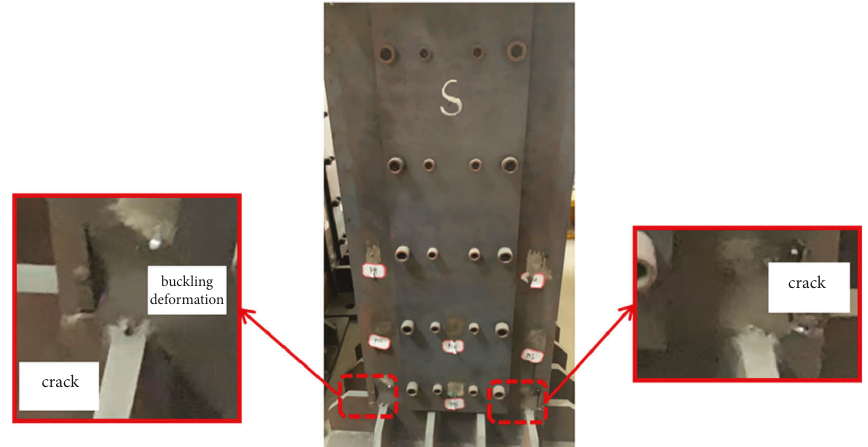
Figure 10: Failure mode of specimen III-1.